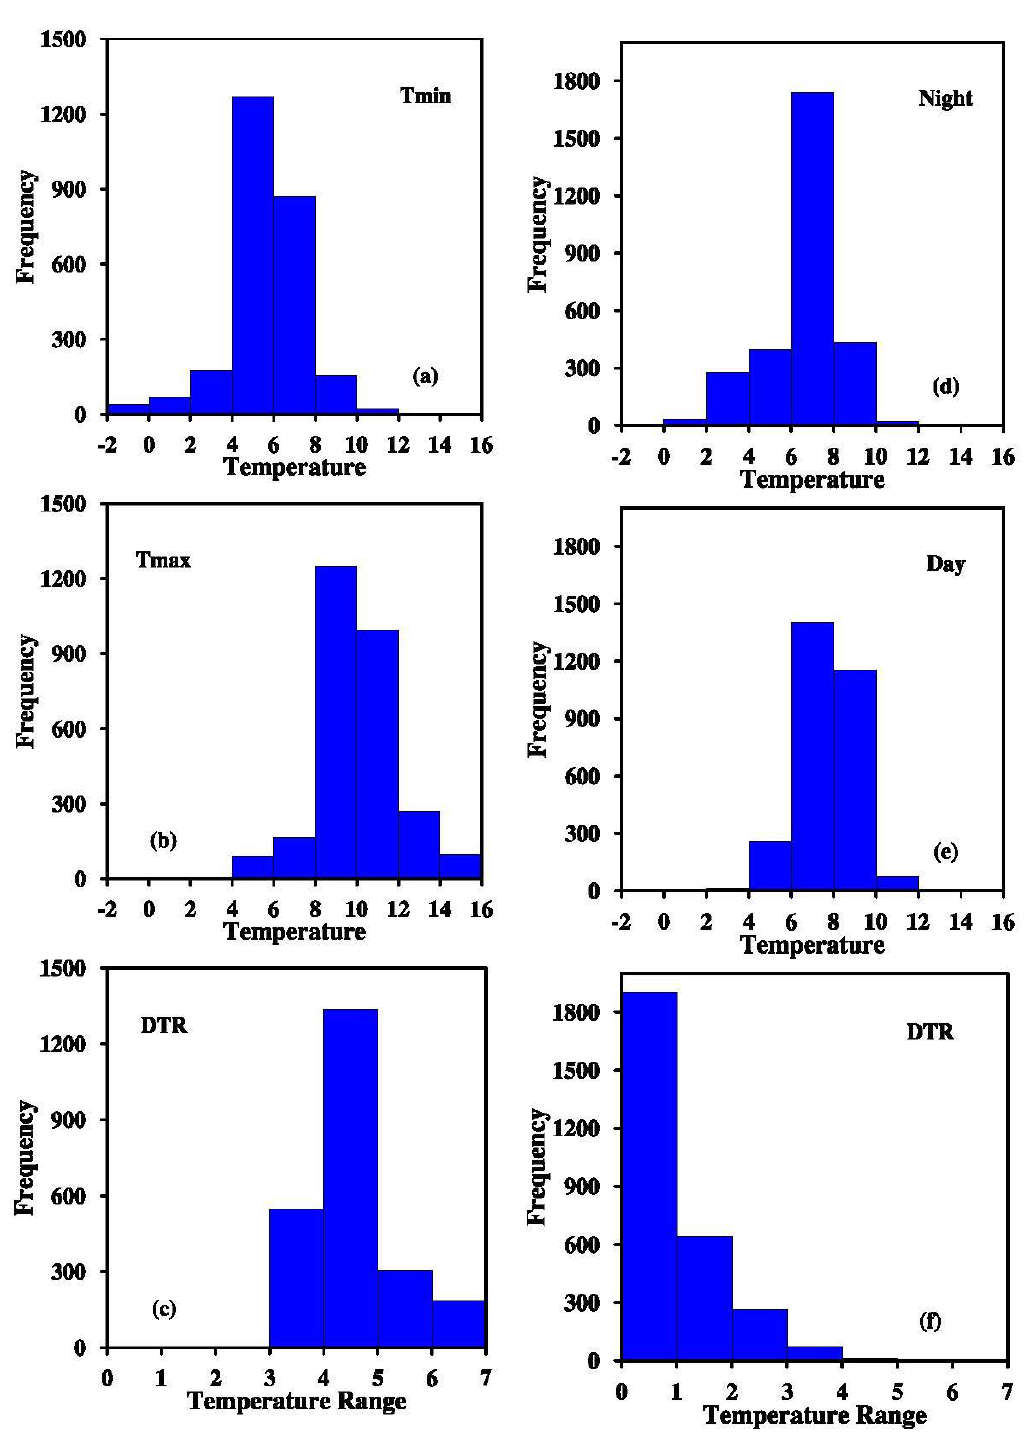
Figure 8. LST frequency distributions for the cases illustrated in Figure 7. Left Column : ( a ) mean values of Min LST; ( b ) mean value of Max LST; ( c ) mean value of DTR as derived from GOES-E UMD; Right Column: same as the left column using information from MOD11C1 (Terra); ( d ) mean value for nighttime; ( e ) mean value for daytime; ( f ) mean value for proxy DTR. All values are averaged for 2004 – 2009.